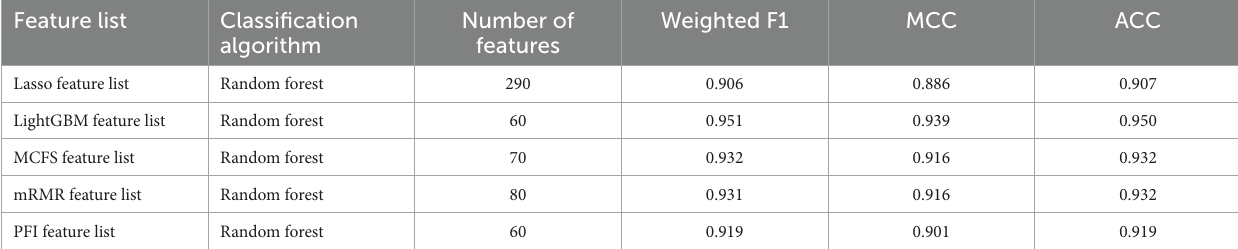
TABLE 4 Performance of feasible classifiers on different feature